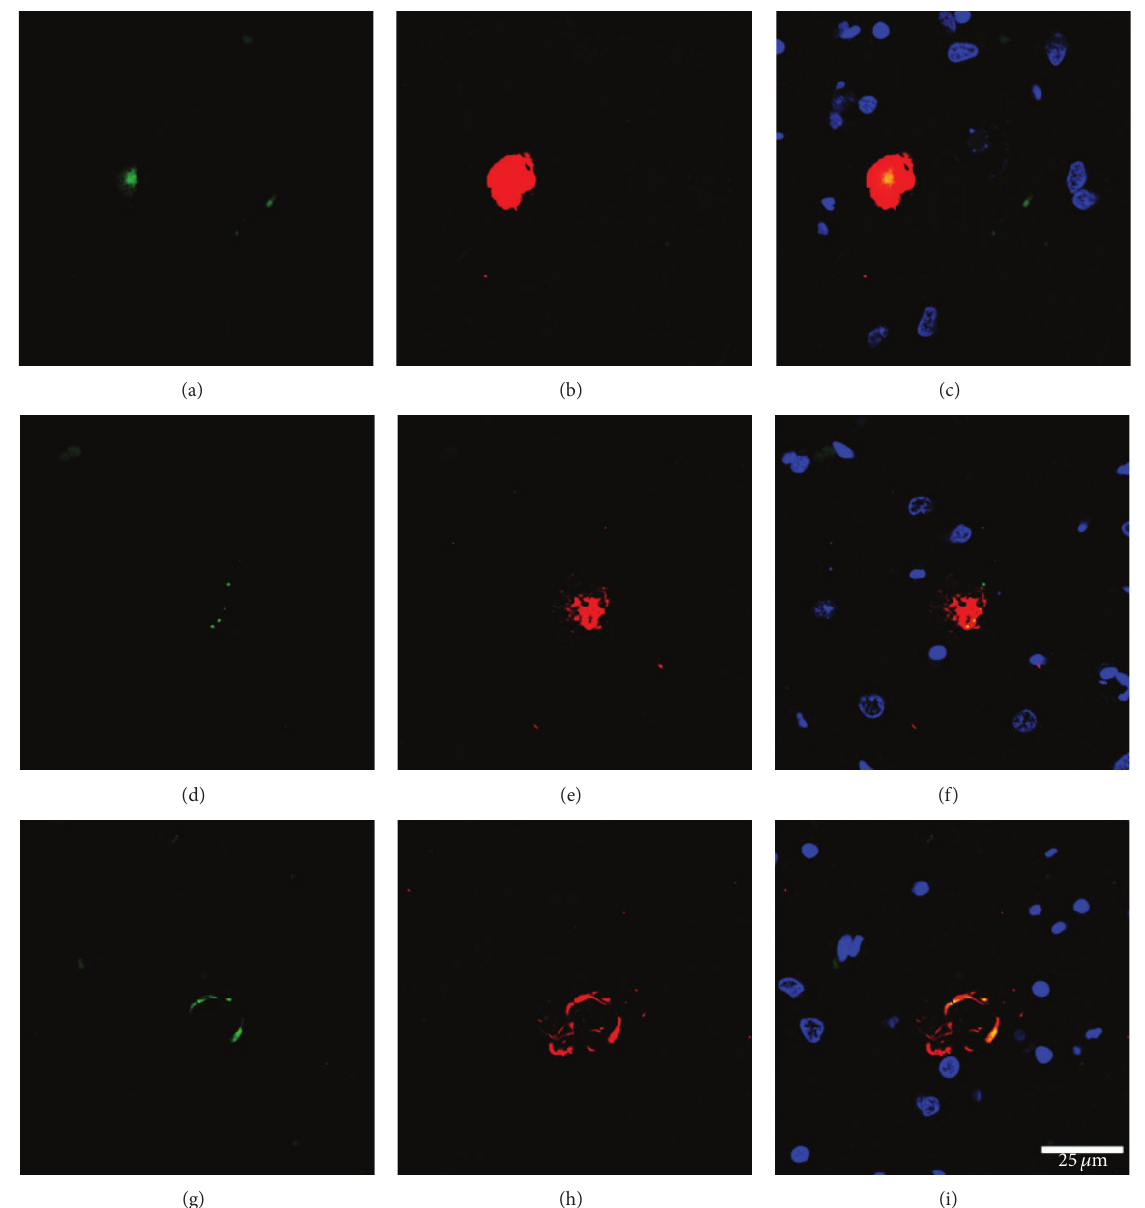
Figure 3: Double-labelling immunofluorescence and confocal microscopy show partial colocalization of IL-10 (green, a, d, g) and phosphorylated TDP-43 Ser409-410 (red, b, e, h) in globular and skein-like inclusions in motor neurons in ALS cases; merge (c, f, i); nuclei (blue) are with DRAQ5; bar = 25 𝜇